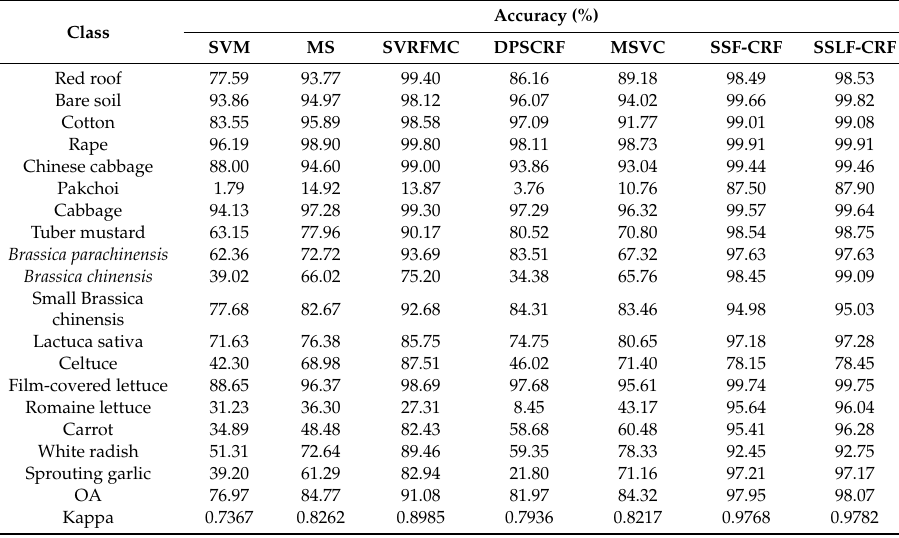
Table 5. The classification accuracies for the Honghu dataset.